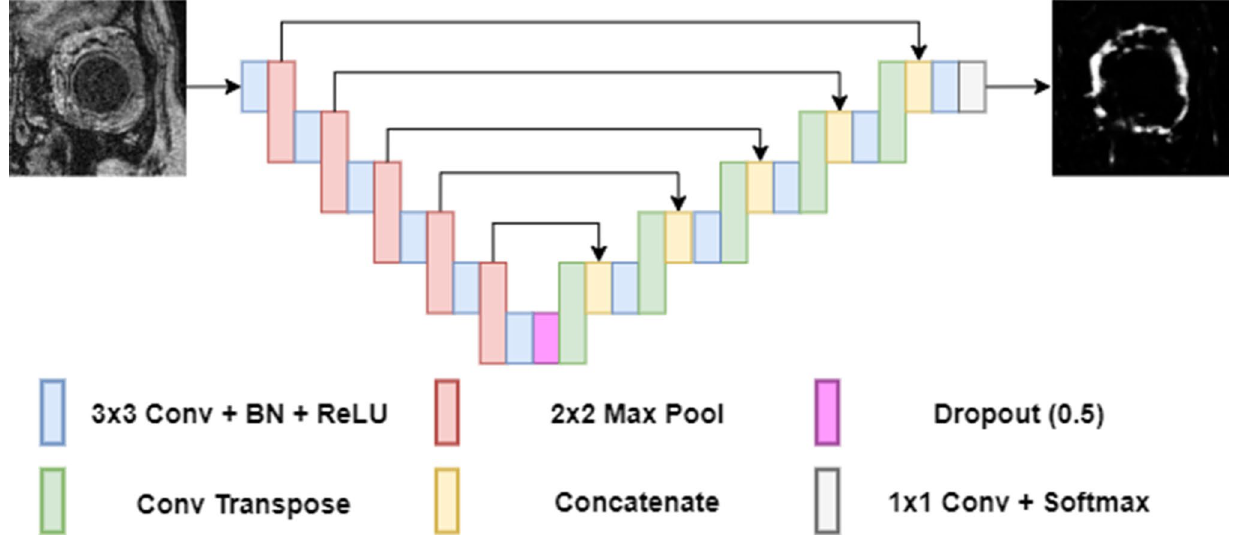
Figure 3. Diagram of the fully semantic neural network (U-net) used in for stages 1 and 2 of the method. An example of the MRI image for the stage 2 (boundary prediction task) is shown. The prediction maps use grey colour scale, where values close to white indicate a high likelihood of a boundary being present. Conv indicates convolutional layer, BN the batch normalization and ReLU the rectified linear activation